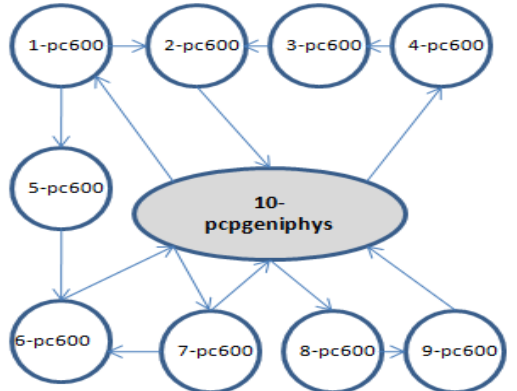
Fig. 30: A network topology which may suffer due to wildcard allocation of